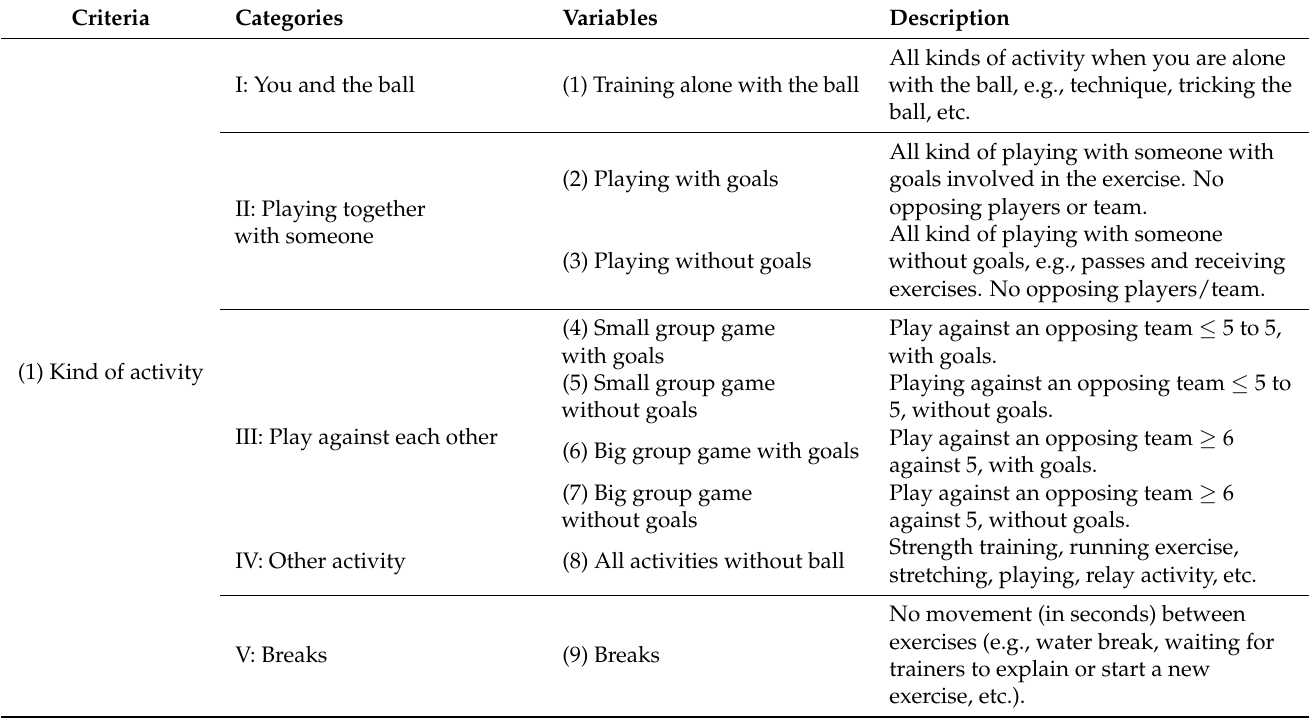
Table 1. An overview of registration on criteria, categories, and